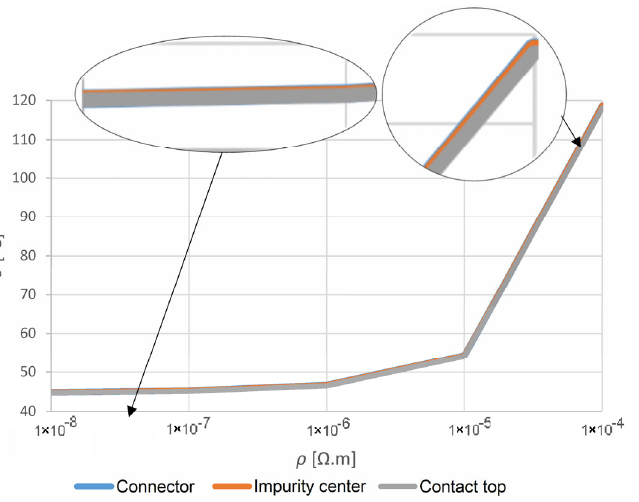
Figure 9. Dependence of impurity resistivity on temperature for high ‐ current copper contacts (for placements: connector, impurity center, and contact top).